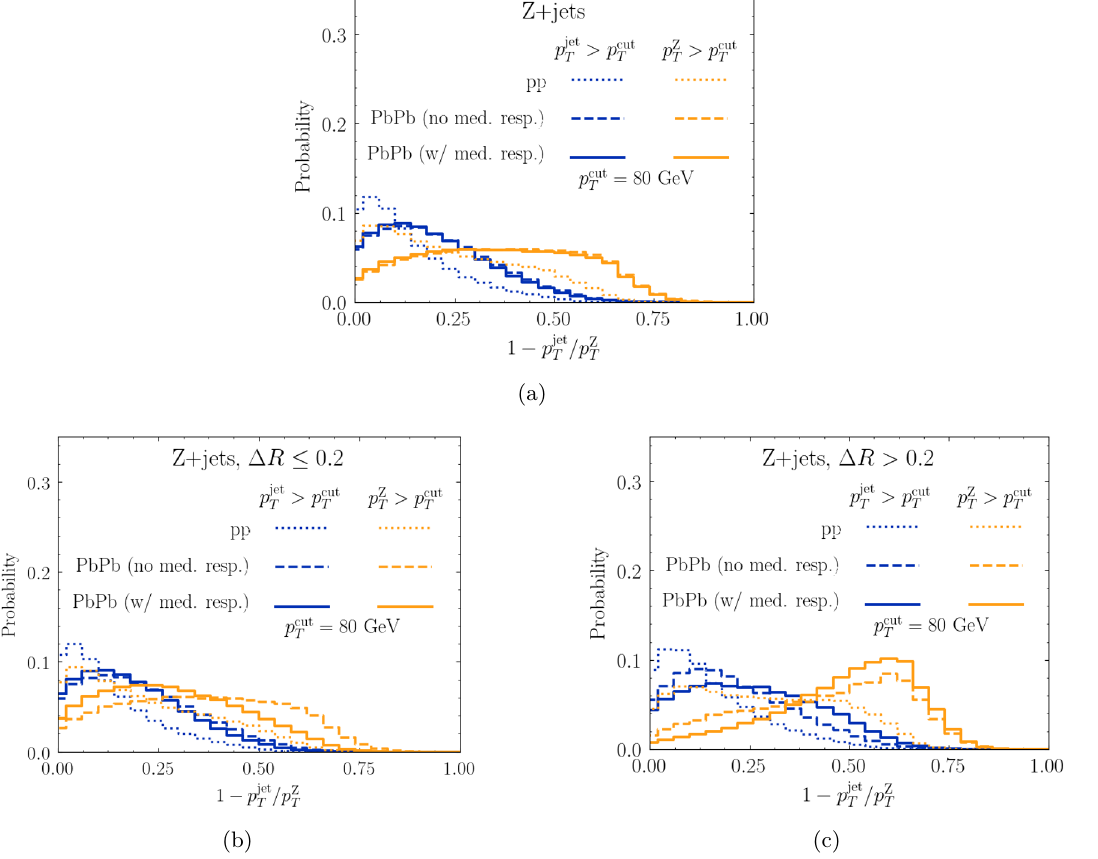
Figure 6. (a) Fractional p T asymmetry between a Z boson and its recoiling jet, for jets with jet p T above 80 GeV (blue) and Z p T above 80 GeV (orange) in vacuum (dotted), and in heavy ion collisions with hadrons originating from medium response artificially excluded from (dashed) or included in (solid) the reconstructed jets. Panels (b) and (c) show the same distributions for those jets with ∆ R ≤ 0 . 2 and ∆ R > 0 . 2 ,